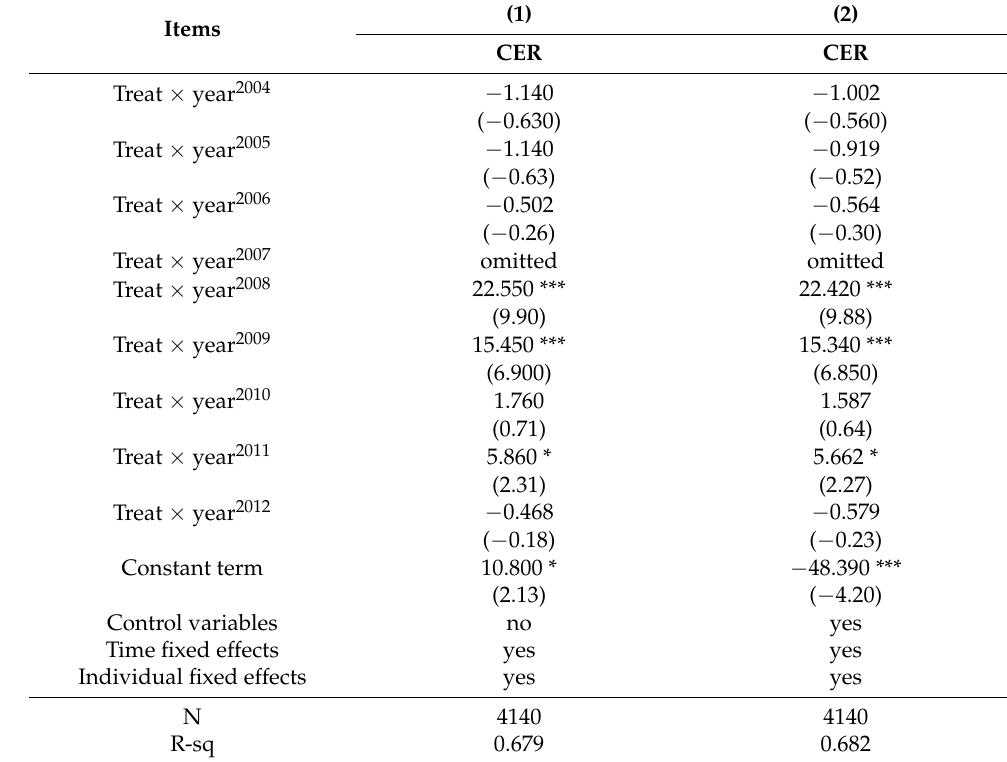
Table 4. Dynamic effects of mandatory CSR disclosure policy on